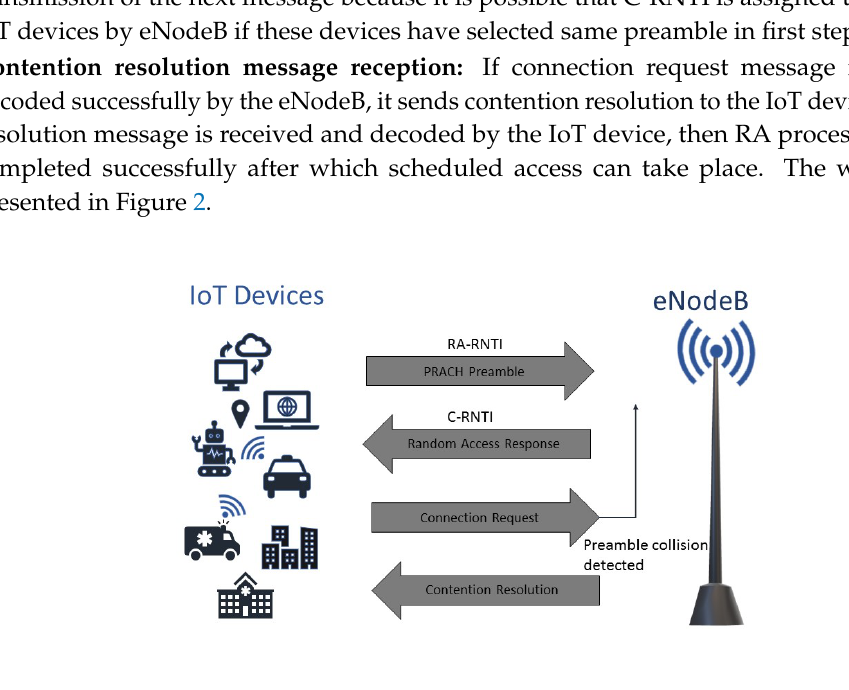
Figure 2. Random Access